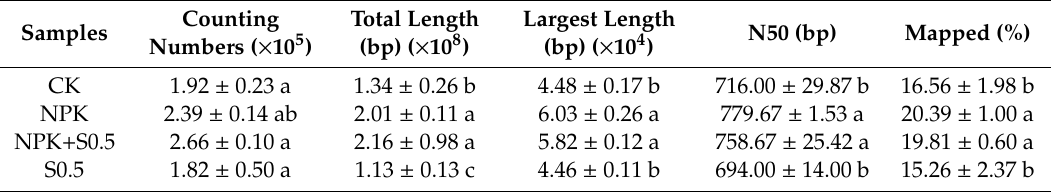
Table A1. Summary of assembled sca ff olds data for metagenomic sequencing.